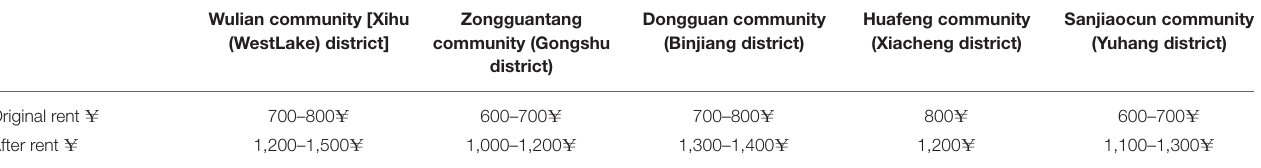
TABLE 2 | The rents of the urban village change we surveyed during centralized urban village